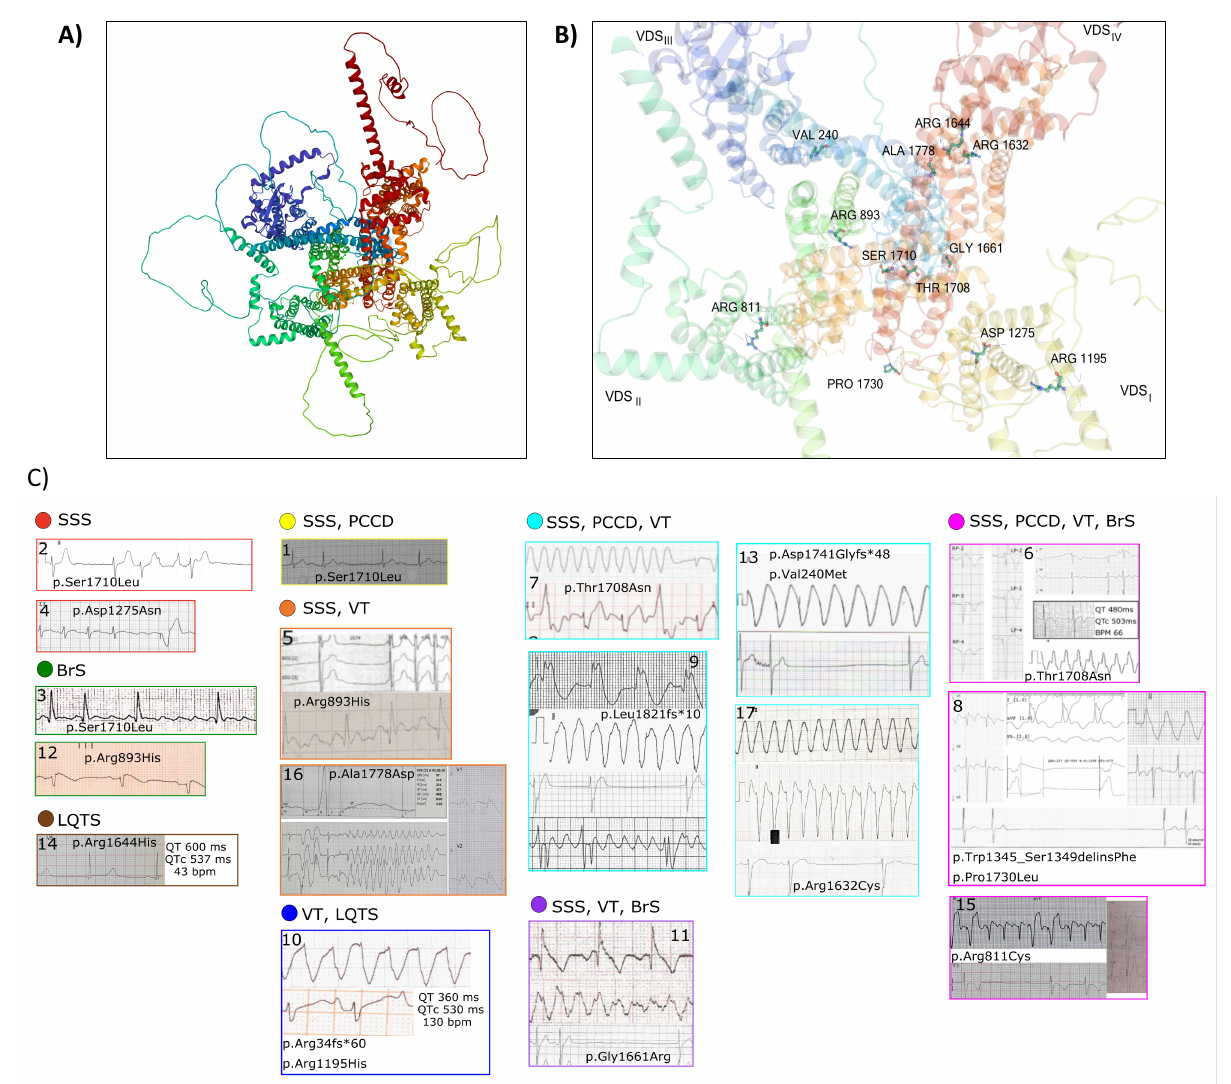
Figure 1. Molecular mapping of the SCN5A mutations. ( A ) Cartoon representation of the over- all structure of Na V 1.5: DI, DII, DIII and DIV domains are colored yellow, green, blue and red, respectively. ( B ) Upper view of the cryo-EM reconstruction of Na V 1.5 using the UniProt (https://www.uniprot.org/uniprot/Q14524, accessed on 28 October 2021) and α Fold templates. SCN5A mutations are indicated as balls and sticks. ( C ) Representative ECGs of probands are pre- sented. The case number is indicated on the ECG image. Cases are ordered according to arrhyth- mogenic phenotypes, SSS: sick sinus syndrome; PCCD: progressive cardiac conduction disease; VT: ventricular tachycardia; BrS: Brugada syndrome; LQTS: long QT syndrome. ECG from Case 2: atrial standstill; Case 4: atrial flutter with VVI pacemaker escape; Case 3: atrial flutter; Case 12: coved type ST elevation and sinus bradycardia; Case 14: sinus bradycardia with prolonged QTc interval (537 ms); Case 1: sinus bradycardia; Case 5: sinus standstill with monomorphic ventricular tachycardia; Case 16: sinus standstill with ventricular fibrillation; Case 10: monomorphic ventricular tachycardia; Case 7: sustained monomorphic ventricular tachycardia; Case 9: severe intraventricular conduction disease, monomorphic ventricular tachycardia, sinus standstill and atrial flutter; Case 13: sustained monomorphic ventricular tachycardia and sinus standstill; Case 17: monomorphic ventricular tachy- cardia and atrial standstill; Case 11: sinus bradycardia, ventricular fibrillation and sinus standstill; Case 6: sinus standstill, prolonged QTc interval (507ms) and sustained monomorphic ventricular tachycardia; Case 8: severe cardiac intraventricular conduction disease, sustained monomorphic ventricular tachycardia and sinus standstill; Case 15: sinus standstill and VVI